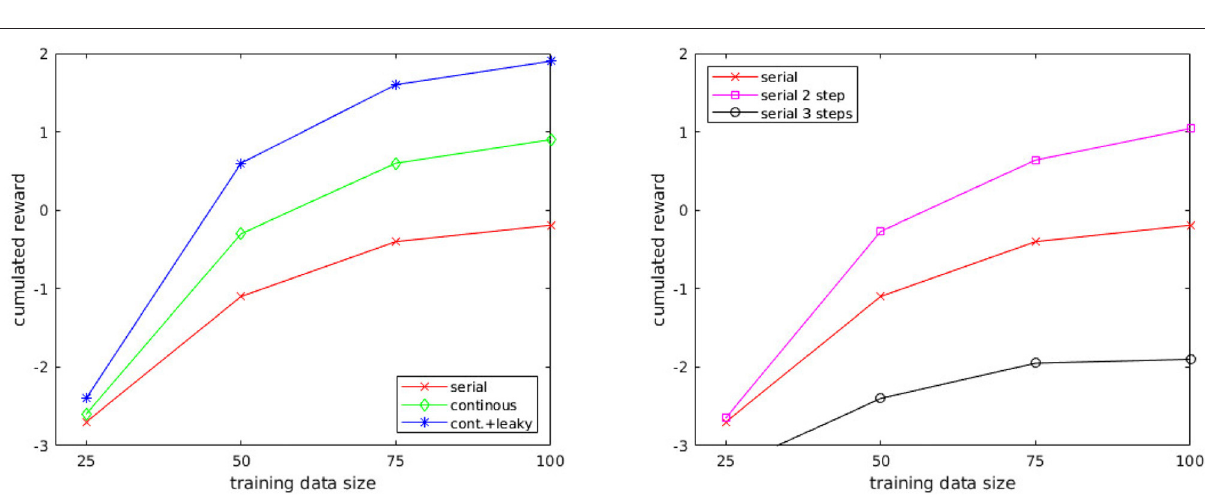
FIGURE 5 | (Left) Comparison of different control processes: serial, continuous, continuous with leaky integrator. (Right) Comparison of the serial control process with different depths: predicting 1, 2, and 3 steps